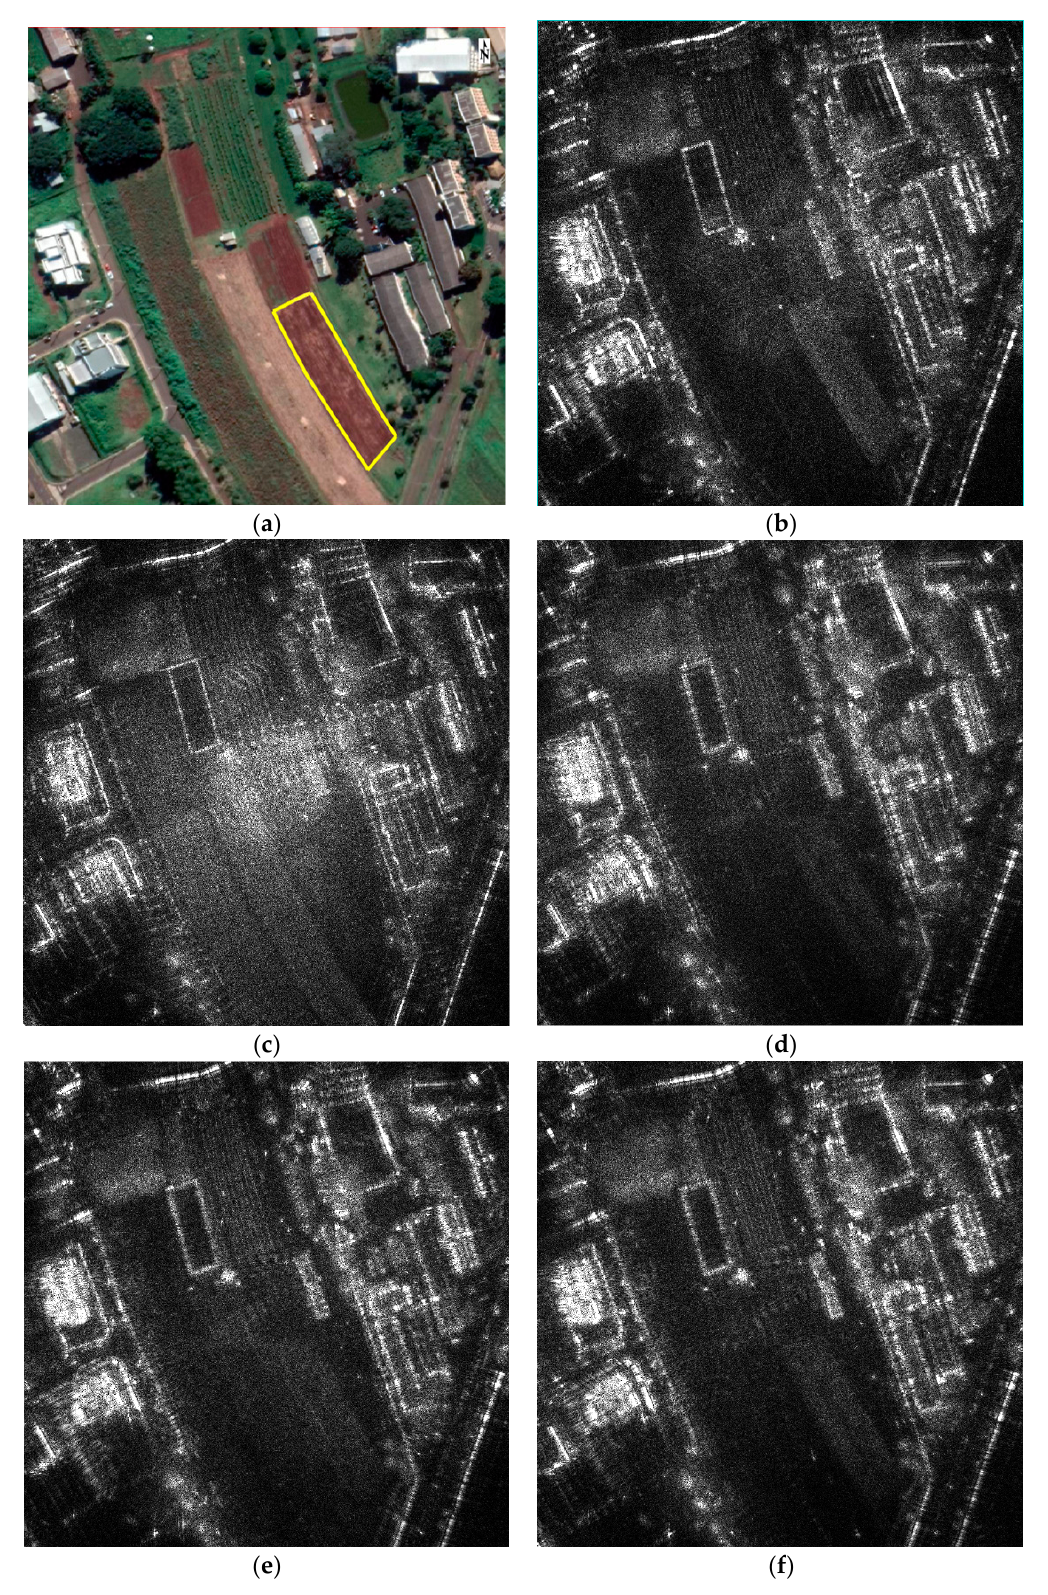
Figure 10. Temporal comparison between ( a ) optical image from Google Earth and drone-borne SAR images of the circular flight tracks, acquired on ( b ) 11 December 2018; ( c ) 17 April 2019; ( d ) 2 July 2019; ( e ) 17 July 2019; and ( f ) 22 August 2019. Field C2 has a yellow border in ( a ).